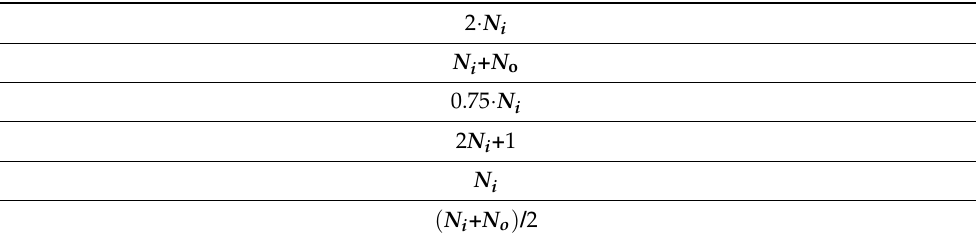
Table 3. Empirical recommendations for determining number of neurons in the first hidden